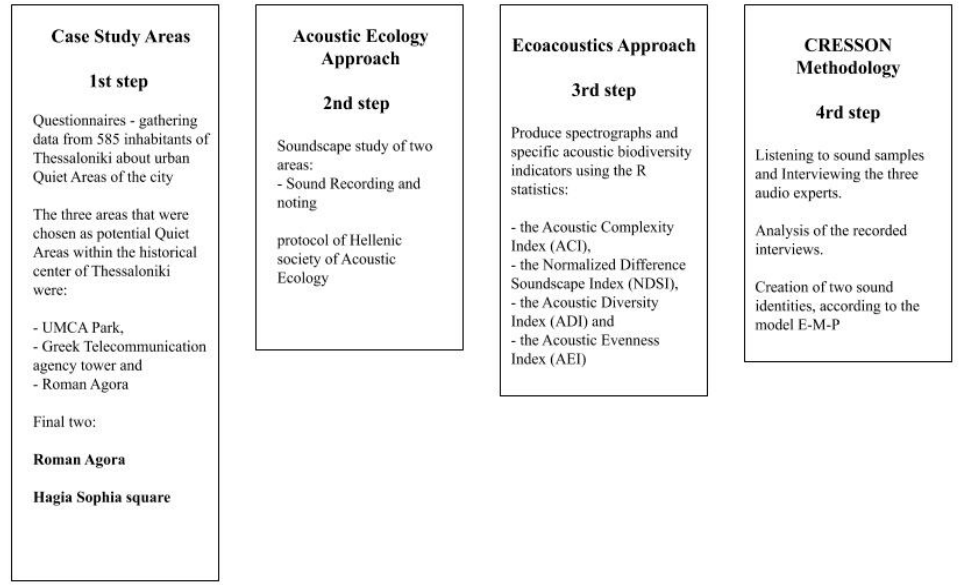
Figure 1. Proposed methodology of the study explained in a